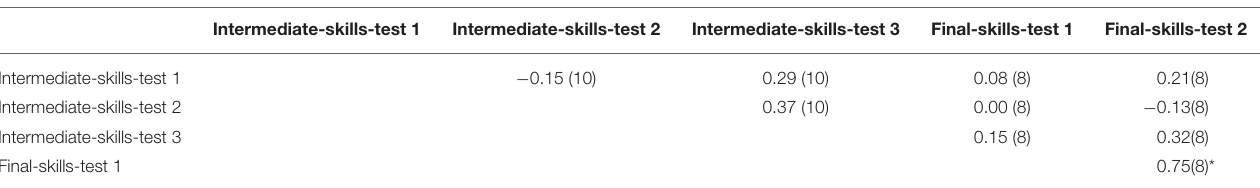
TABLE 3 | Correlation (Kendall’s tau) between all test